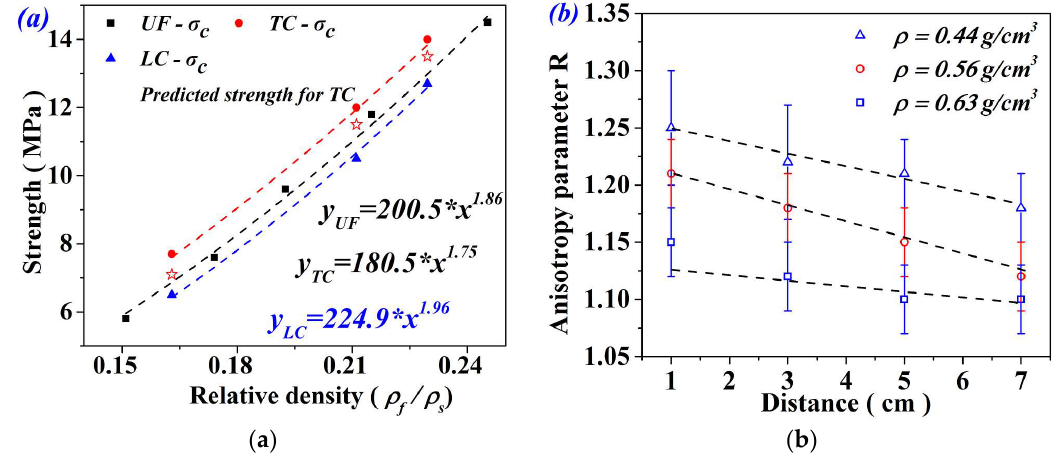
Figure 7. ( a ) Compressive strength of UF and FG aluminum foams and ( b ) anisotropy parameter.